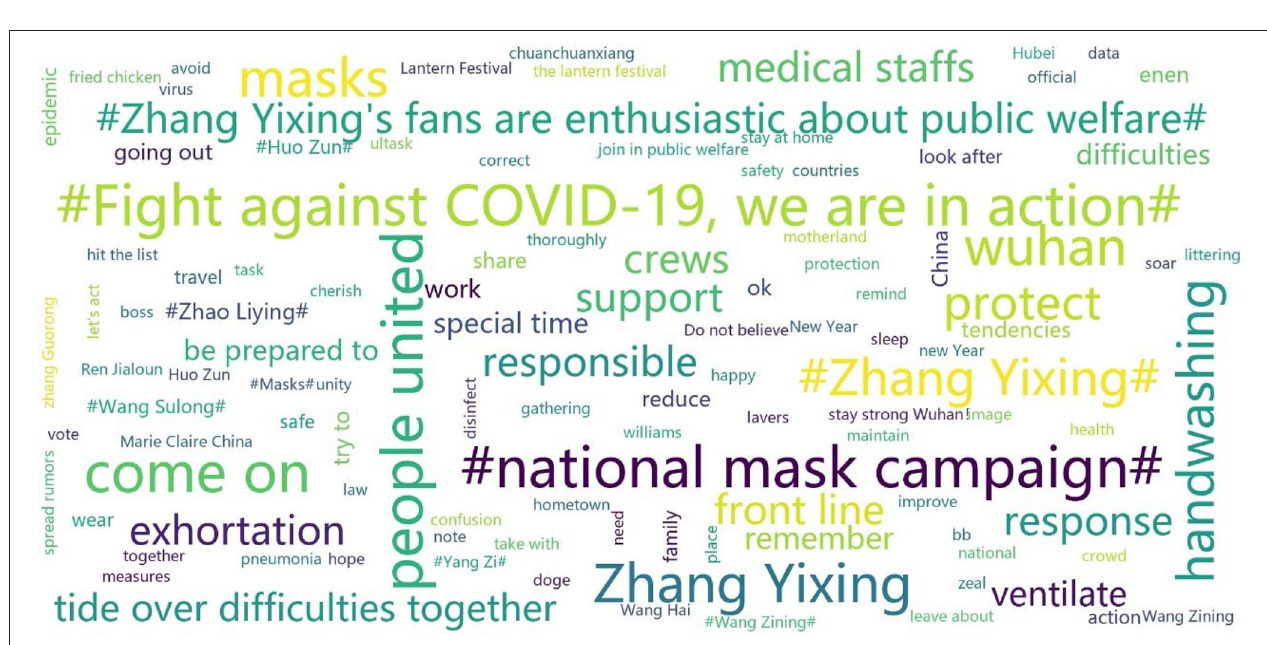
FIGURE 2 | Word cloud of “#national mask campaign#” on Sina